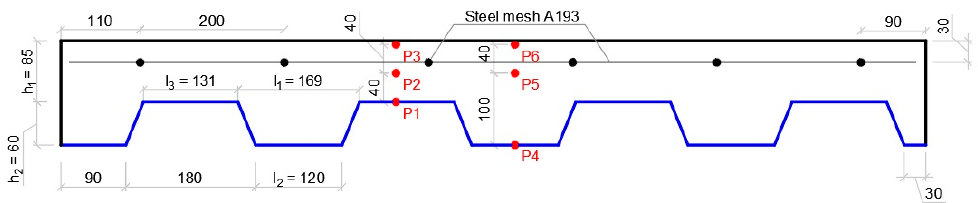
Figure 2. Geometric arrangements of the tested composite slabs (Adapted with permission from Guo and Bailey [16]). Red dots (P1-P6) represent the position of the thermocouples, Black dots rep- resent the steel mesh.